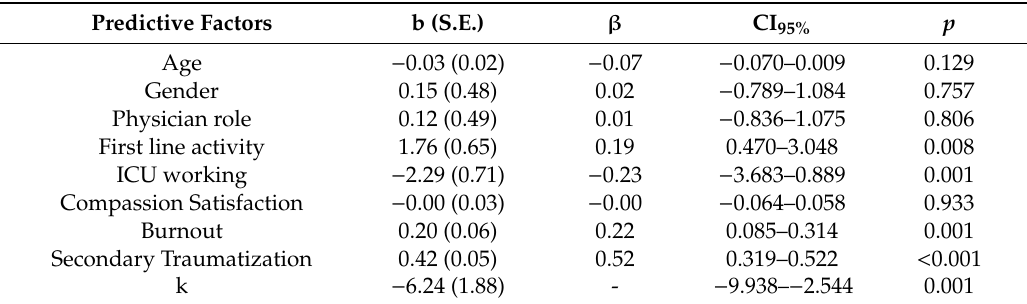
Table 3. Linear regression model: sociodemographic variables and ProQOL-5 subscales scores as predictive variables associated with GAD-7 score in the total sample (N =